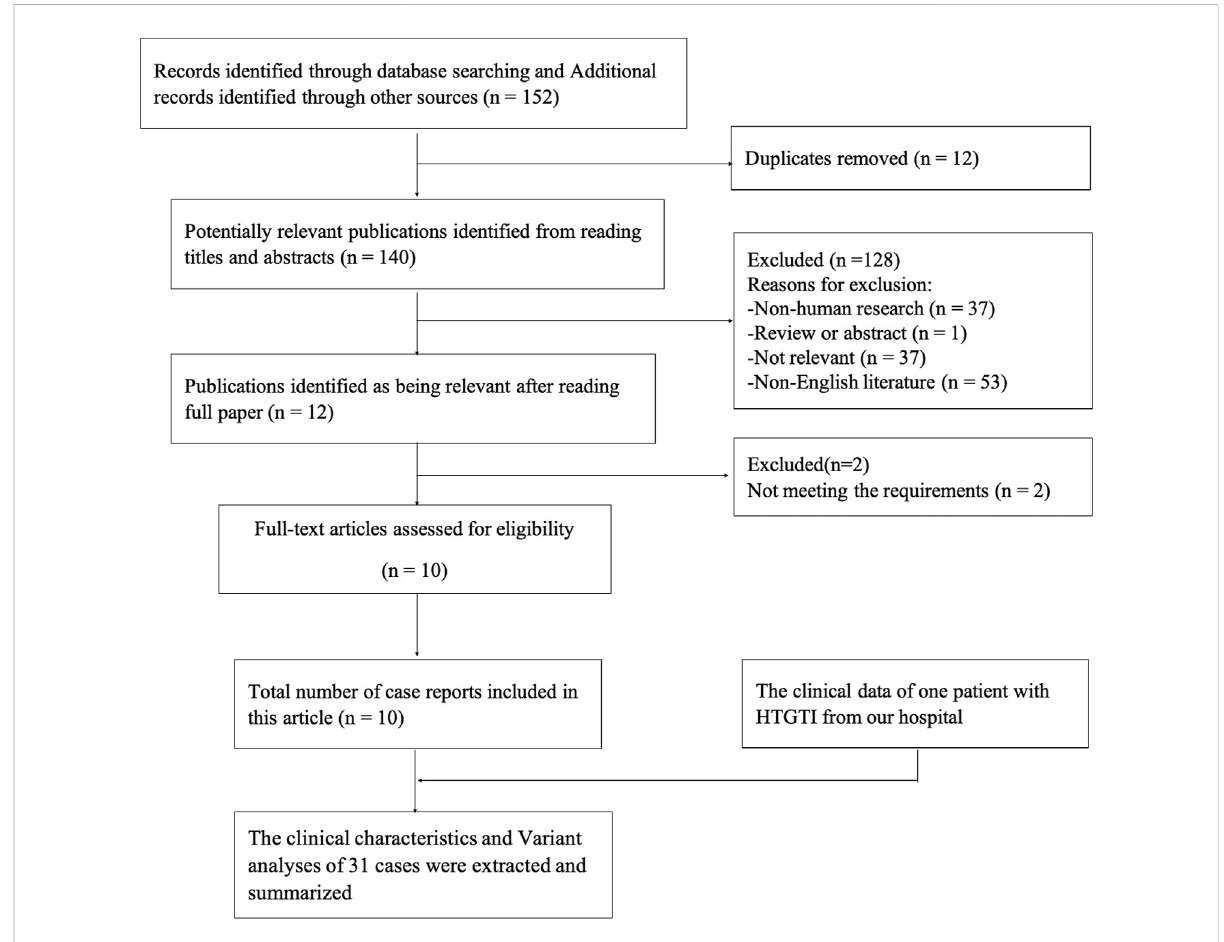
FIGURE 1 The fl ow diagram of the research